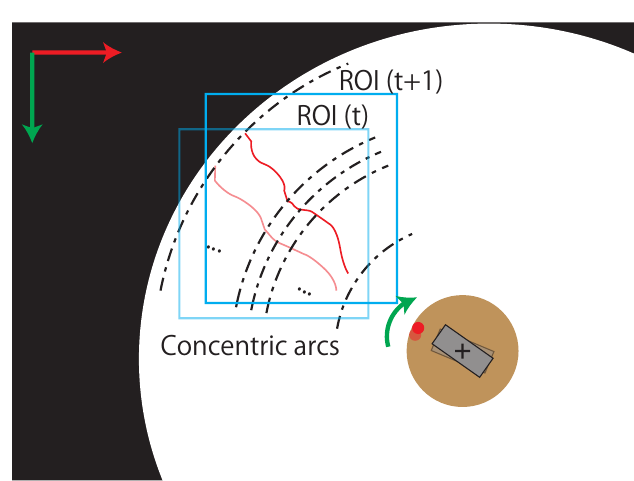
Figure 6. Concentric arcs and ROIs for fast and accurate extraction of bright points. To calibrate the normal vector n of the line laser, the image coordinate ( i u c (cid:48) , i v c (cid:48) ) T of the bright point C (cid:48) , which is shown in Figure 2, is utilized. The bright point C (cid:48) is on a circular reference plane fixed to the direct drive motor. When the position of the line laser is defined such that a part of the line laser is irradiated on the fixed reference plane, the image coordinate of C (cid:48) changes dynamically depending on the rotation of the direct drive motor. The correspondence relationship between the image coordinate of C (cid:48) and the normal vector n of the line laser is utilized by a polynomial-fitting-based calibration [20]. In the calibration, the intrinsic parameter of the omnidirectional camera and a normal vector n of the line laser are calculated using Zhang’s method [21]. Simultaneously, the image coordinate of the bright point C (cid:48) on the reference plane is calculated. By changing the direction of the line laser and repeating the process, multiple correspondences between the normal vectors n of the laser plane and the image coordinates of the bright point C